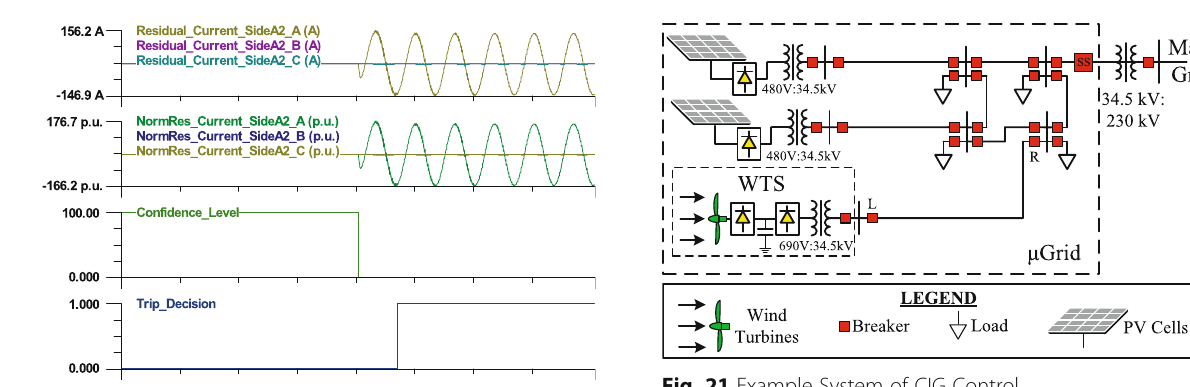
Fig. 21 Example System of CIG Control